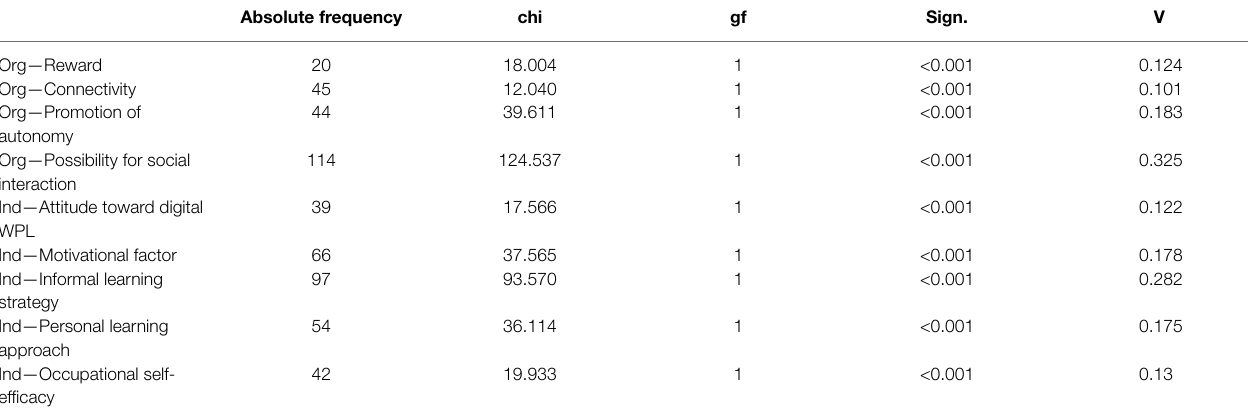
TABLE 5 | Co-occurrence between individual (Ind) and organisational (Org) factors and the sub-category ‘support learning’. Absolute frequency chi gf